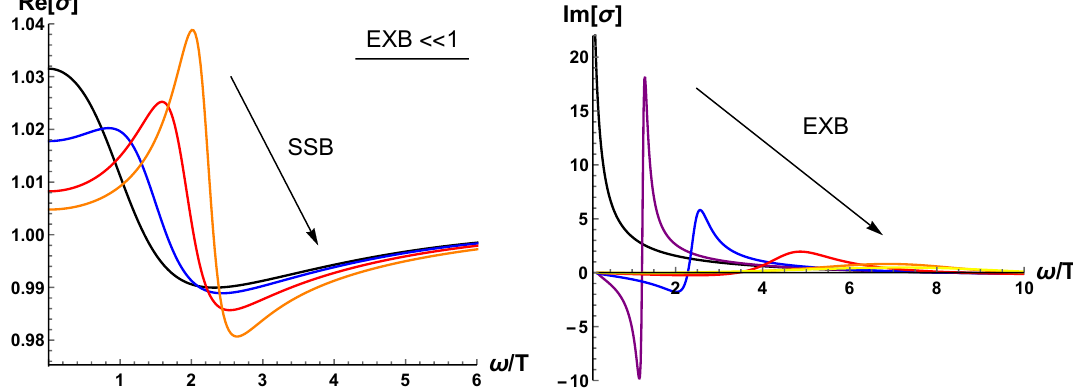
Figure 7 . Left: real part of the electric conductivity increasing the strength of SSB starting from a situation with a small but (cid:12)nite EXB. From black to orange the breaking becomes more and more spontaneous. We (cid:12)xed T=m = 1 and (cid:22)=T = 0 : 5. From black to orange increasing (cid:12) 2 [1 ; 10]. The transition from a Drude peak to a coherent pinned response is evident. Right: imaginary part of the conductivity starting from a pure SSB situation (black line) and adding EXB. This plot is done using the potential V ( X ) = A X + B X 5 . The transition is now from a i=! pole to a pinned response going at larger and larger frequencies and being more and more damped until disappearing.